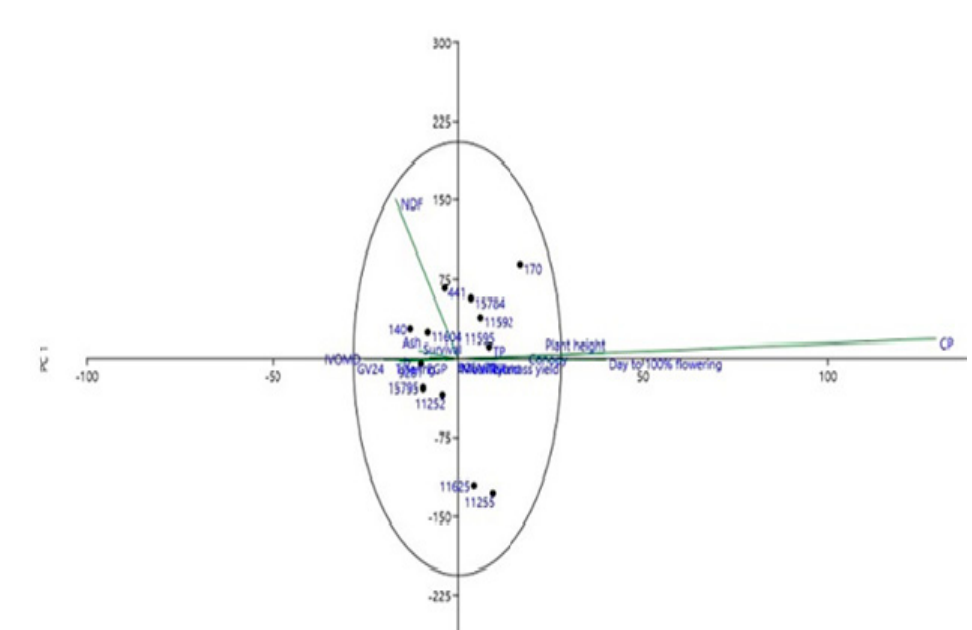
Figure 3. Principal component plot of different S. scabra accessions for all parameters measured.